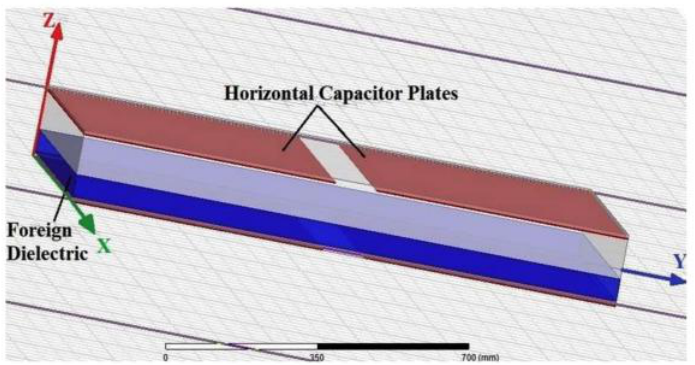
Figure 14. A dielectric foreign object in a single module CPT system in ANSYS Maxwell. Environ-